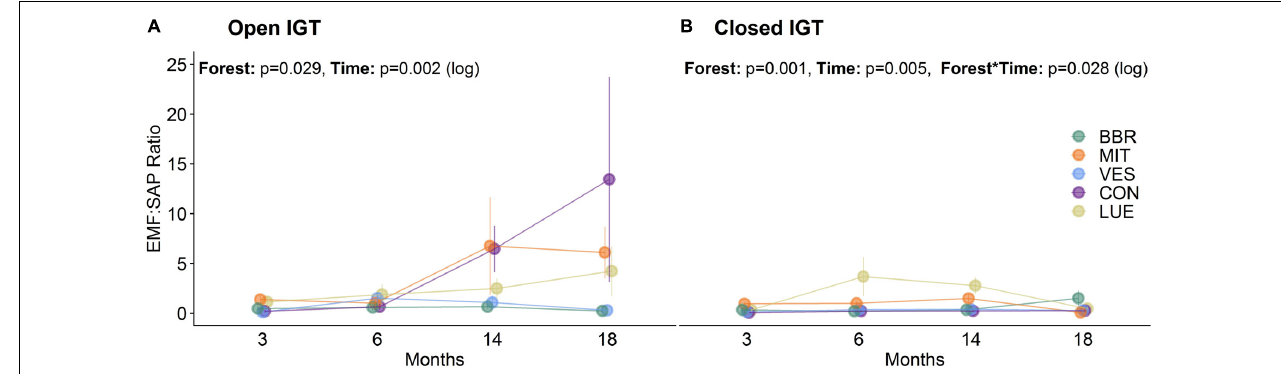
FIGURE 1 | Ratio of ectomycorrhizal to saprotrophic fungi (EM:SAP) in (A) open ingrowth tubes (IGTs) and (B) closed IGTs based on absolute number of OTUs in Bad Brückenau (BBR), Mitterfels (MIT), Vessertal (VES), Conventwald (CON), and Lüss (LUE) over 18 months of exposure ( n = 5). TABLE 2 | Relative proportion of ectomycorrhizal (EM) and saprotrophic (SAP) fungi OTUs in open and closed ingrowth tubes (IGTs) based on Illumina sequencing in Bad Brückenau (BBR), Mitterfels (MIT), Vessertal (VES), Conventwald (CON), and Lüss (LUE) over 18 months of exposure ( n = 5). Parameter Exposure Time (months) EM fungi (% OTU) SAP fungi (% OTU) Open IGT Closed IGT Open IGT Closed IGT